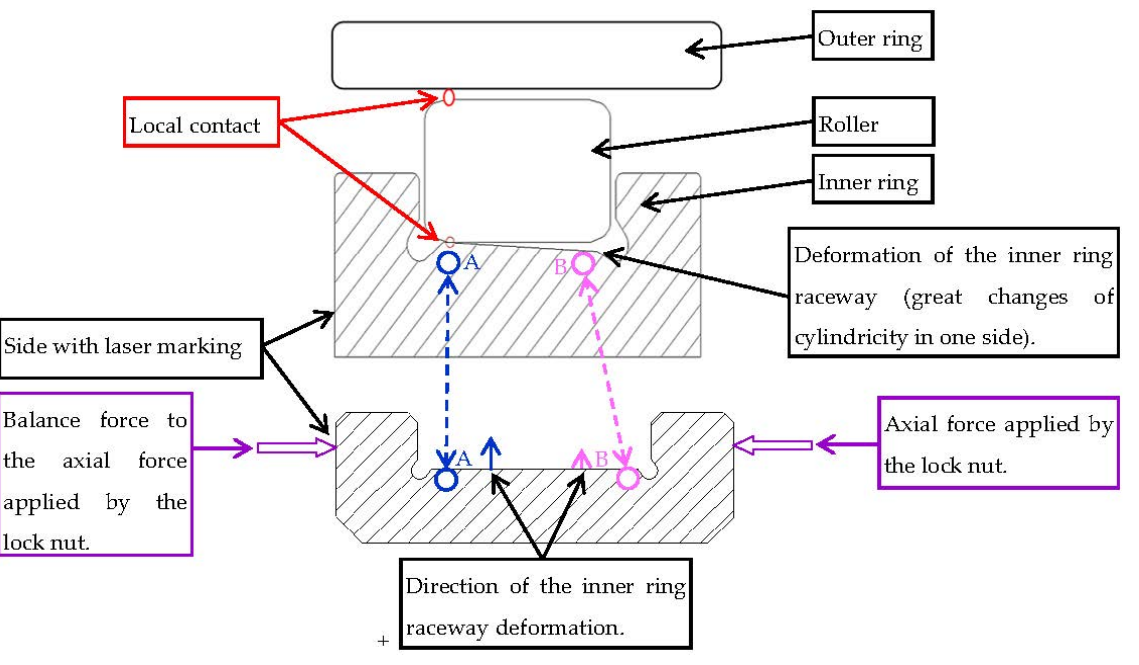
Figure 4. Schematic of unilateral local contact between inner ring raceway and roller.